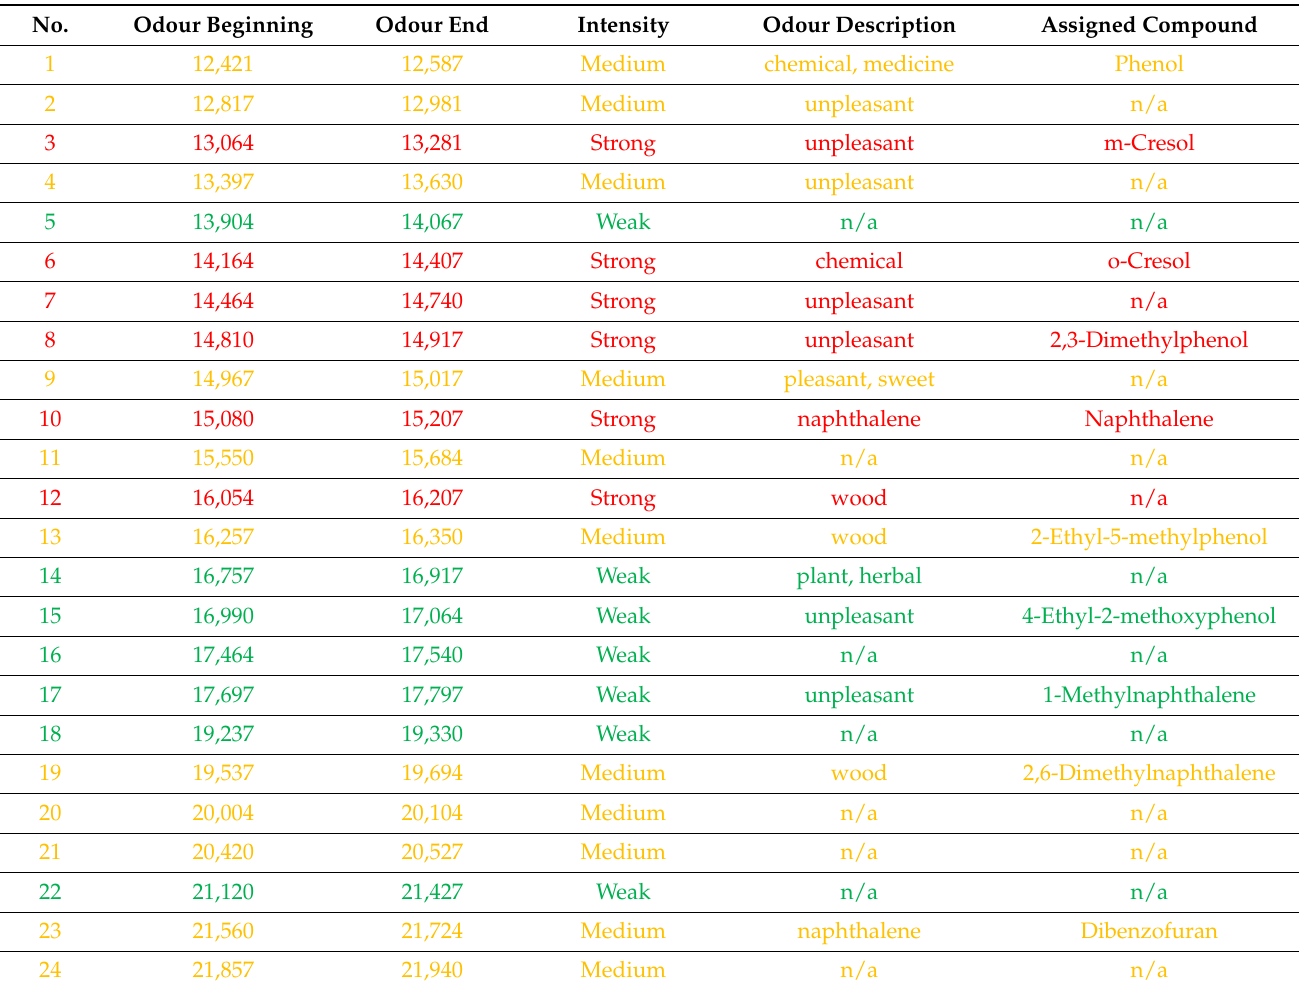
Table 4. Identification of the signals obtained for the samples of floor staves exposed to elevated desorption